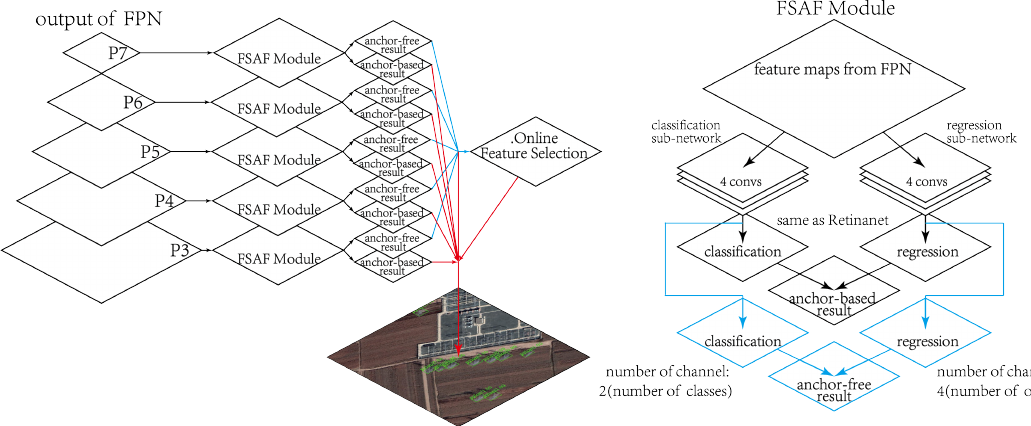
Figure 14. Structure of Retinanet FSAF [41]. Retinanet FSAF combines an anchor-free module, FSAF module, with Retinanet [29]. The right part shows the structure of FSAF module, which has the same anchor-based branch as Retinanet. The blue part shows the structure of anchor-free branch. Regression sub-network outputs four channels which present four offsets, while the classification sub-network outputs two channels which present two categories. IoU loss [51] and focal loss [29] are used as regression and classification loss, respectively. The left part shows the global structure of Retinanet FSAF. Blue lines mean utilizing the results of anchor-free branch to select the best feature levels for training objects, while the red ones represent object detection on the selected feature map. Details of feature map selection can be found in